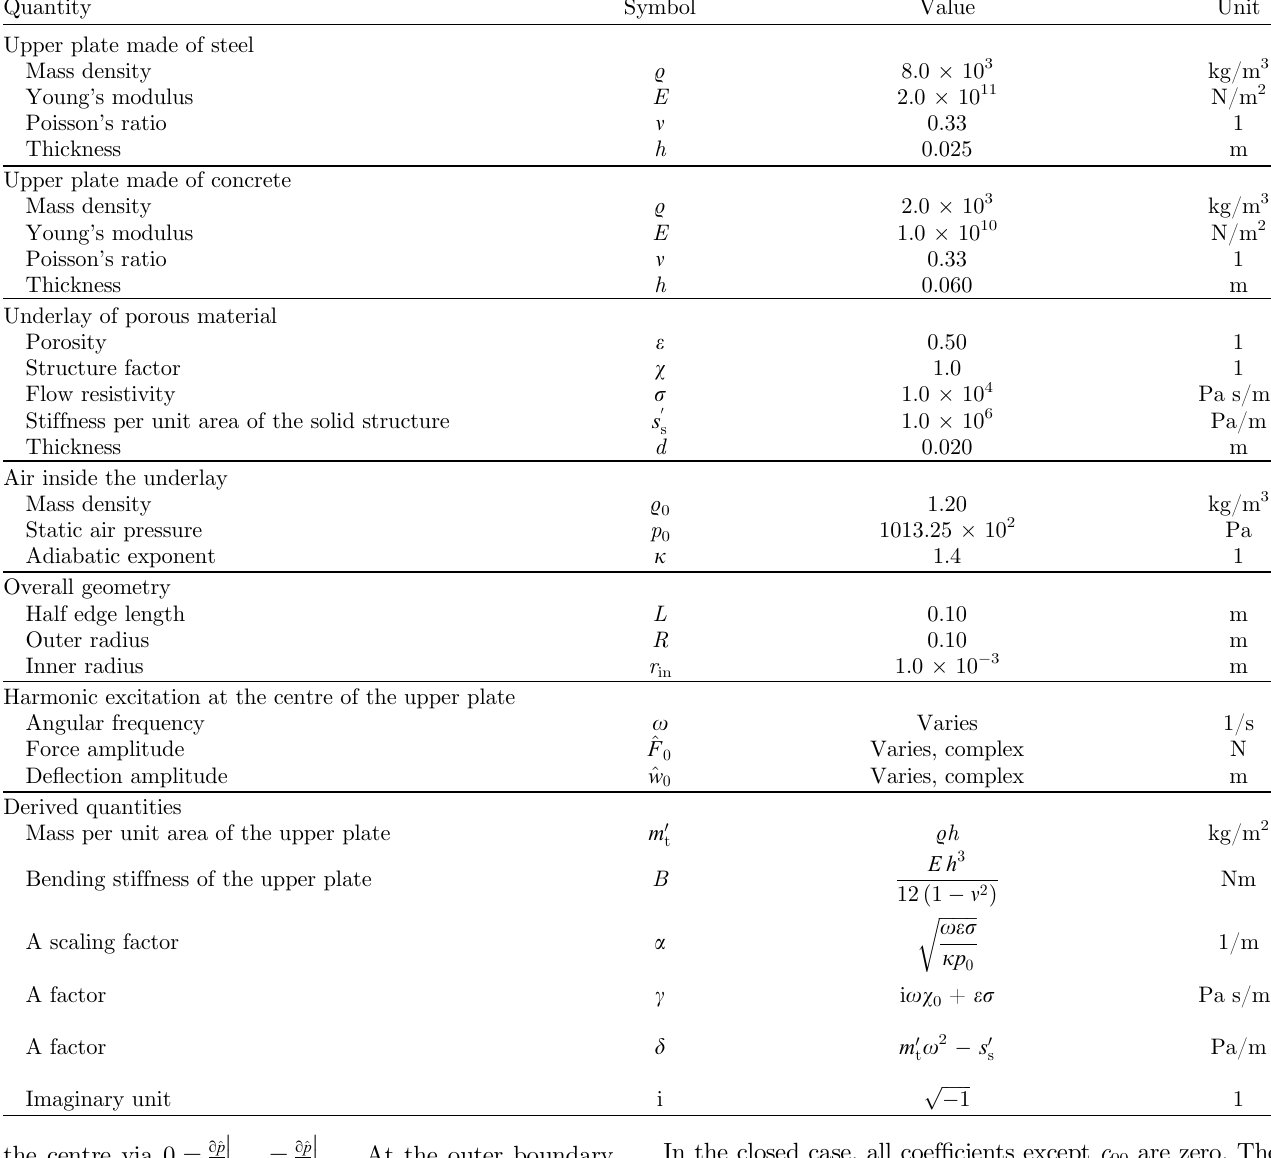
Table 1. Basic quantities and their